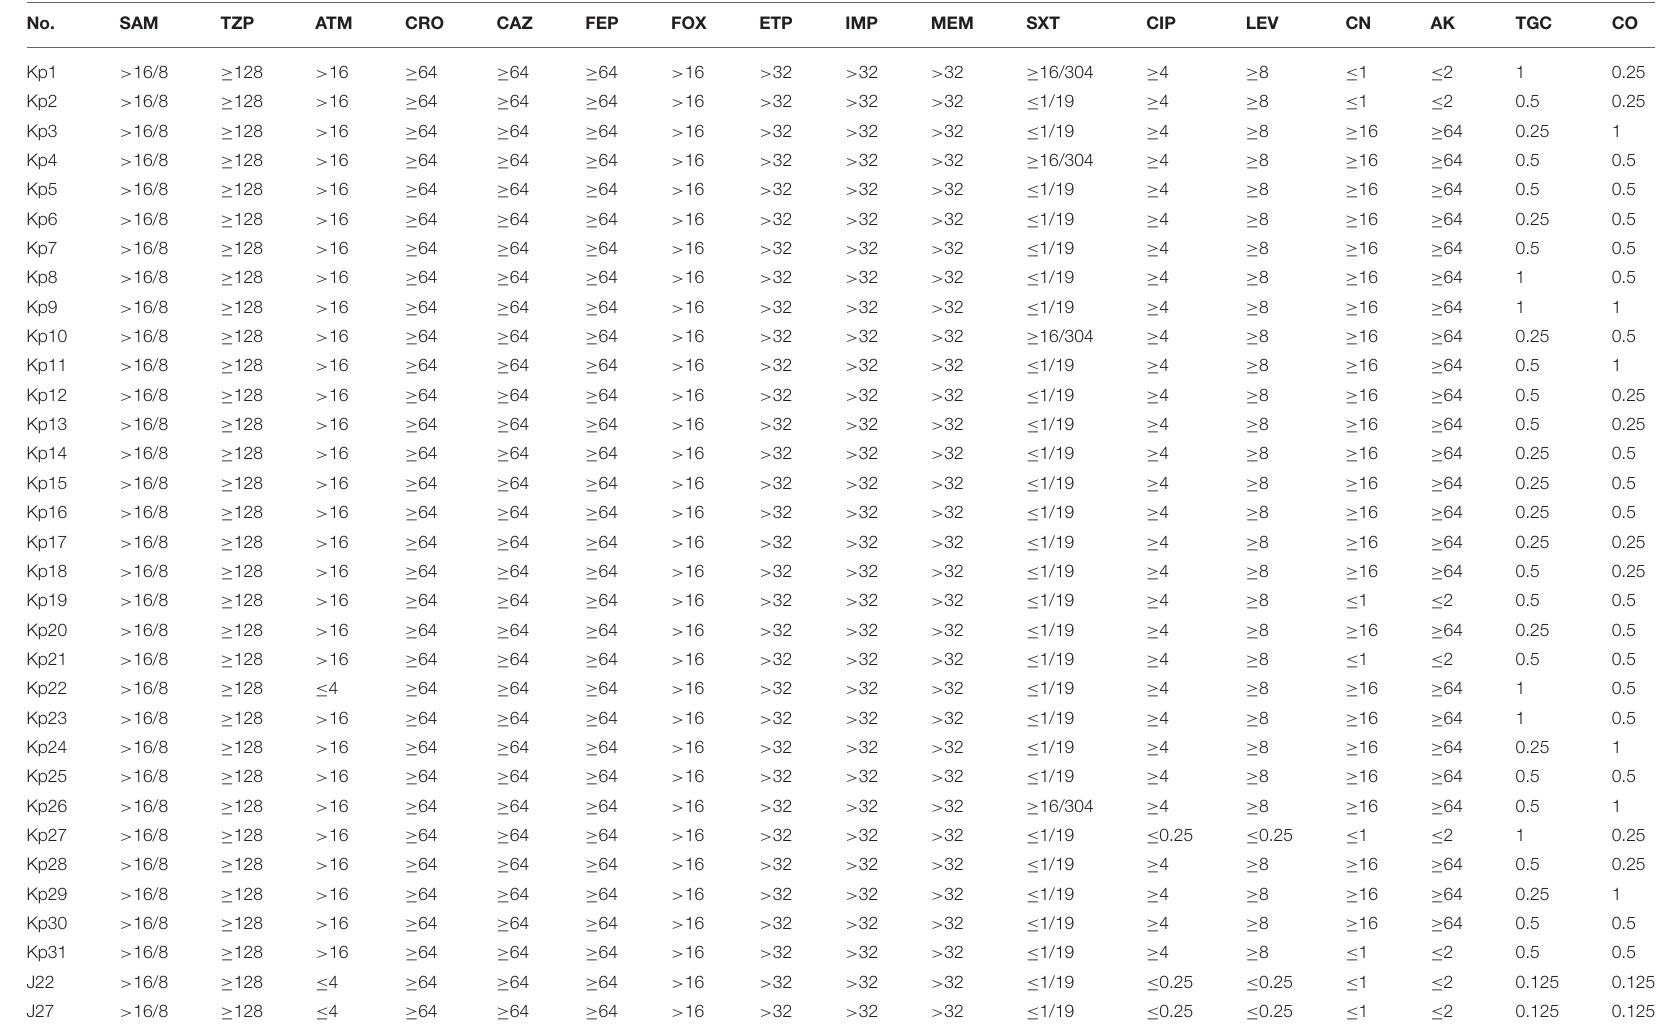
TABLE 2 | The MIC of 31 CRKp isolates and two transconjugants ( µ g/mL).